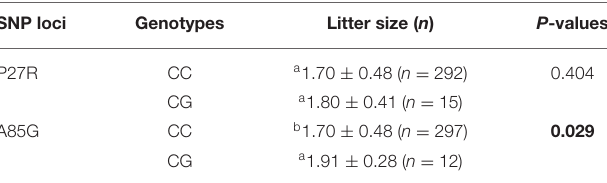
TABLE 5 | Relationship between SNP loci of the GDF9 gene and litter size in Shaanbei white cashmere (SBWC) goats.